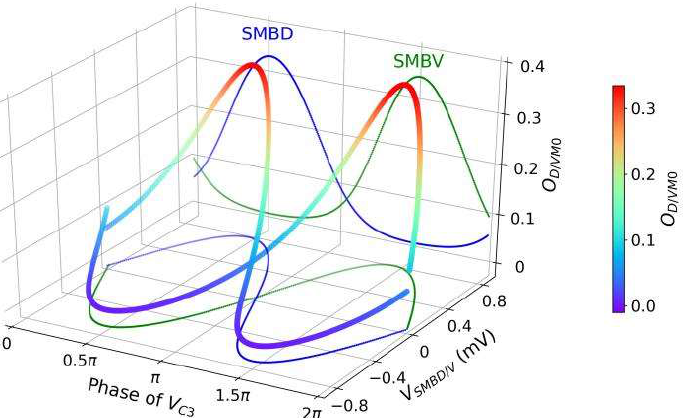
Figure 3. Dynamics of SMBD/V motoneuron and D/VM0 muscle in the absence of sensory input. The solid-colored curves are the projections of three-dimensional (3D) curves onto each plane.